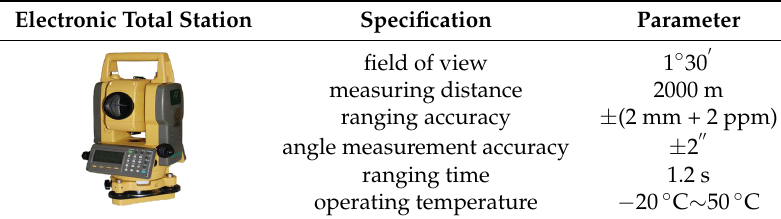
Table 5. The electronic total station